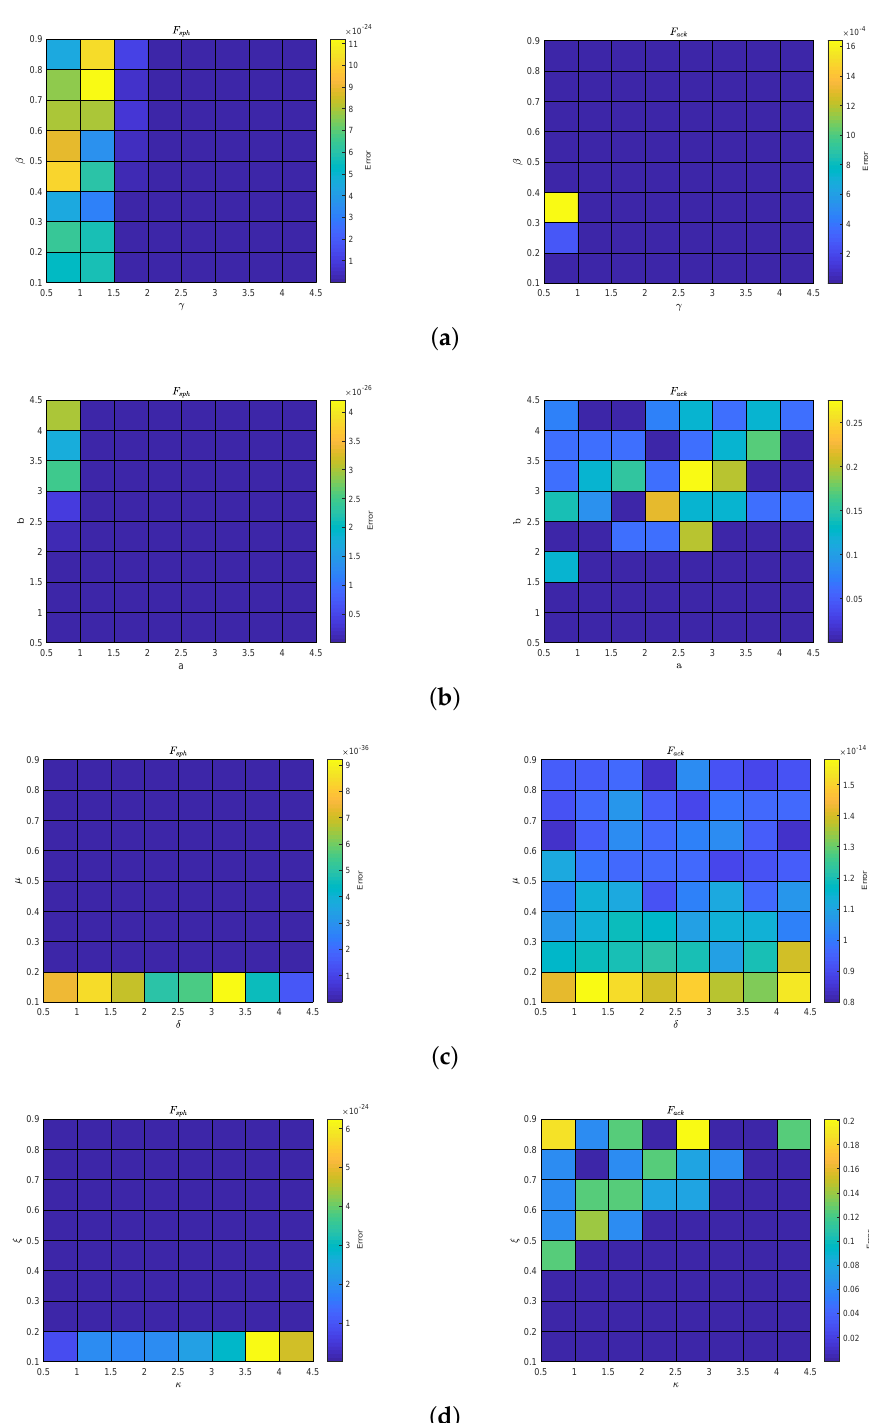
Figure 1. Impact of user-defined parameter values of CSML, CSP, CSC and CSW on the results for selected benchmark functions. ( a ) CS with the Mittag-Leffler distribution, CSML. ( b ) CS with the Pareto distribution, CSP. ( c ) CS with the Cauchy distribution, CSC. ( d ) CS with the Weibull distribution,